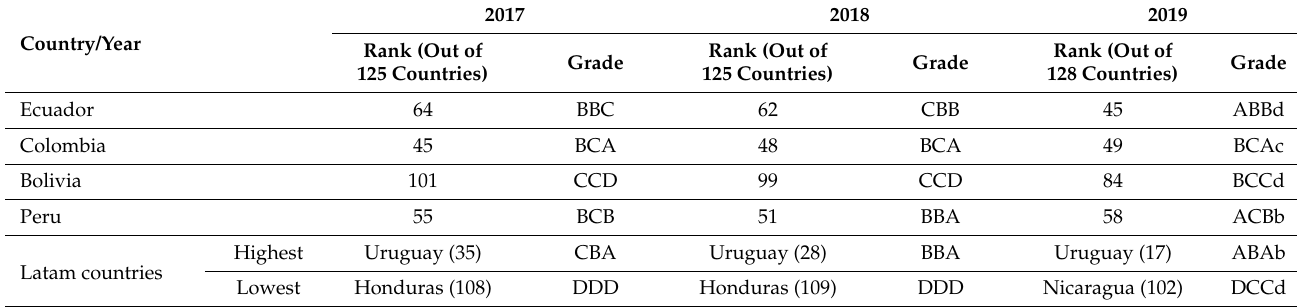
Table 2. Energy sustainability indices of the Andean Community